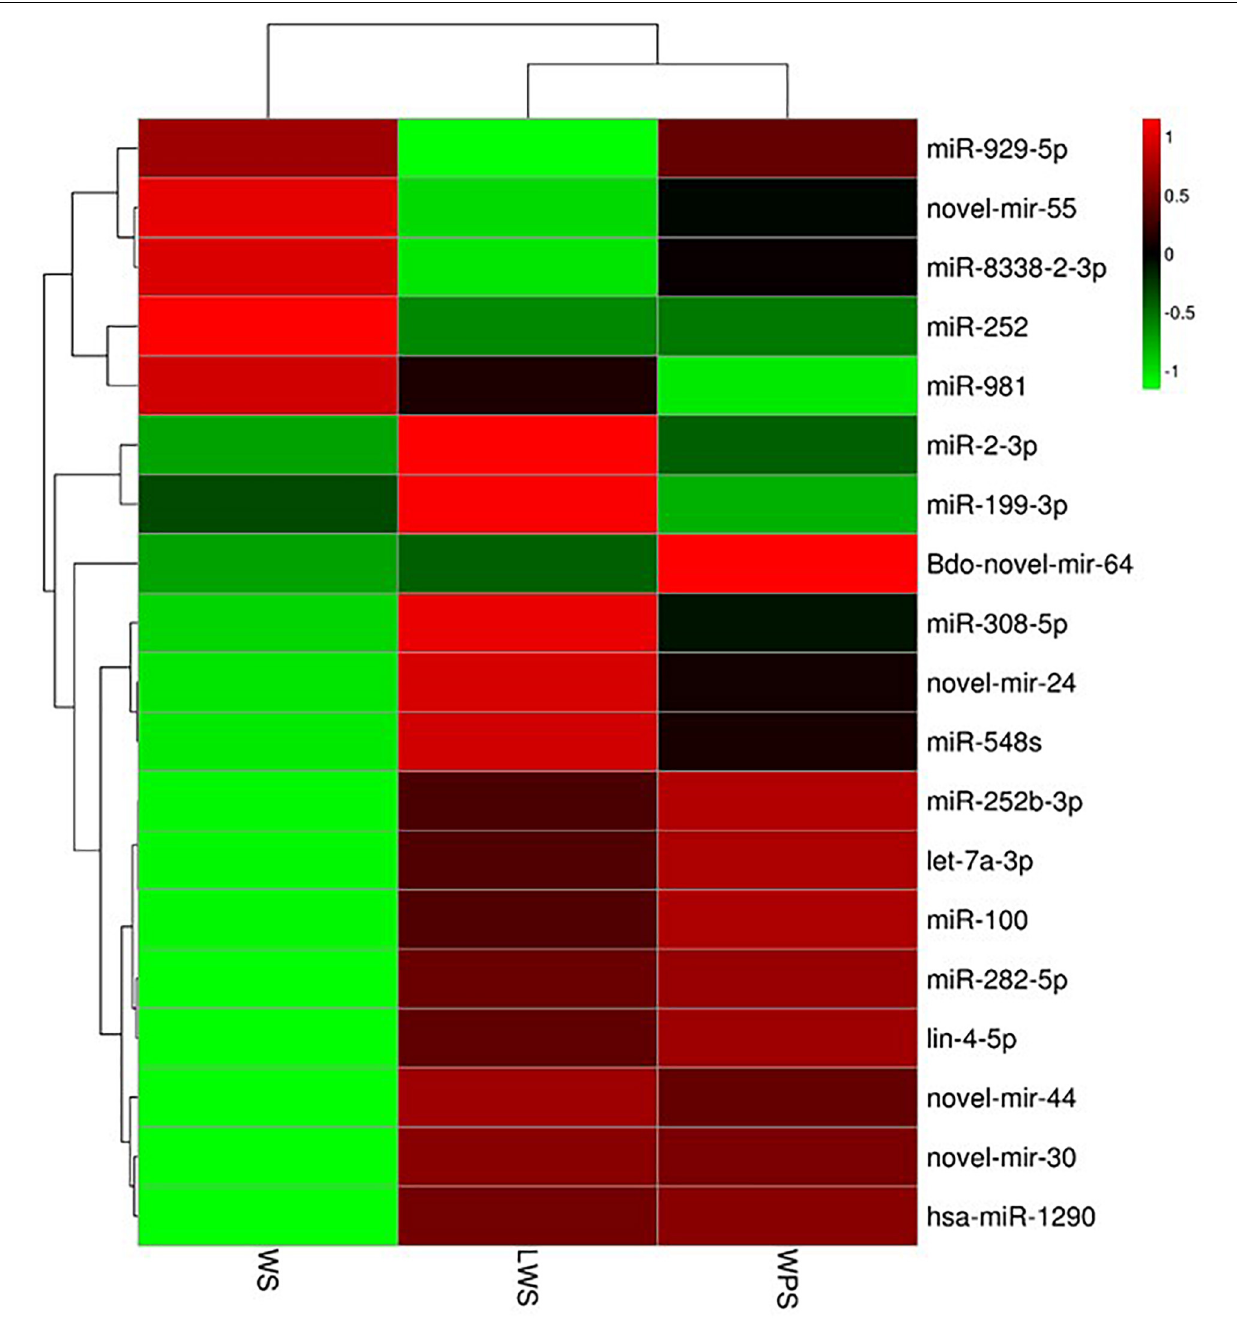
FIGURE 2 | Cluster heat map showing the differential expression of B. dorsalis miRNAs over the three stages. (Parameter setting: data adopt the logarithm: log 10 and normalization; clustering by row and column).